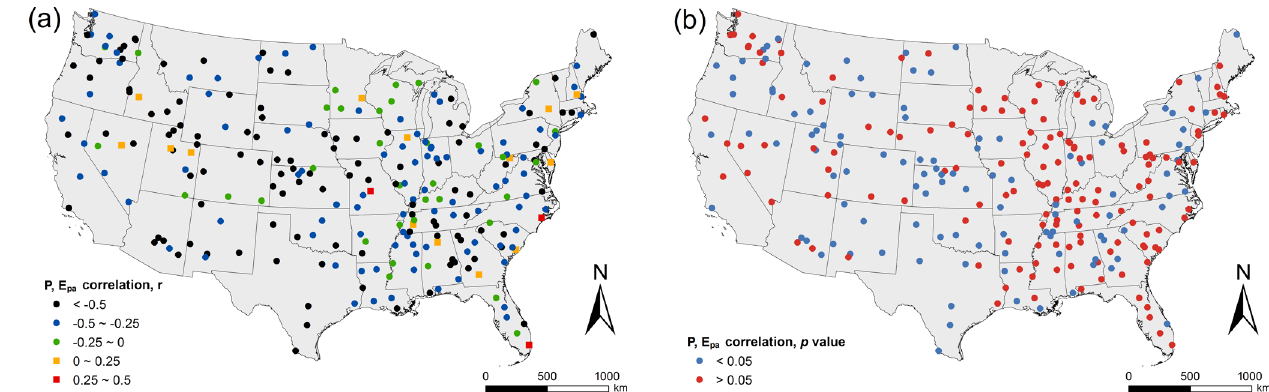
Figure 4. Map of the point-scale annual P – E pa correlation at 259 weather stations: (a) r value and (b) p value.